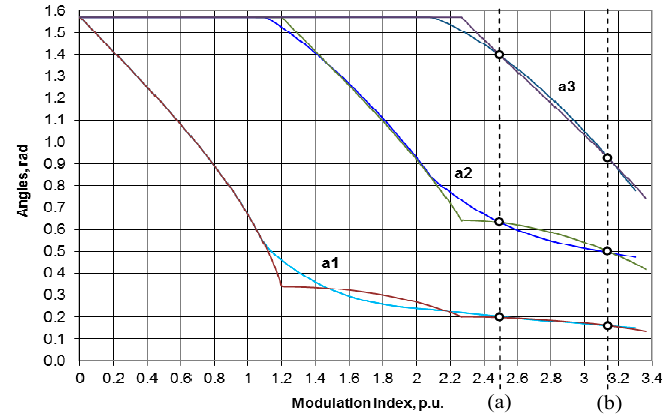
Figure 12. Voltage and current optimal switching angles for n = 3.